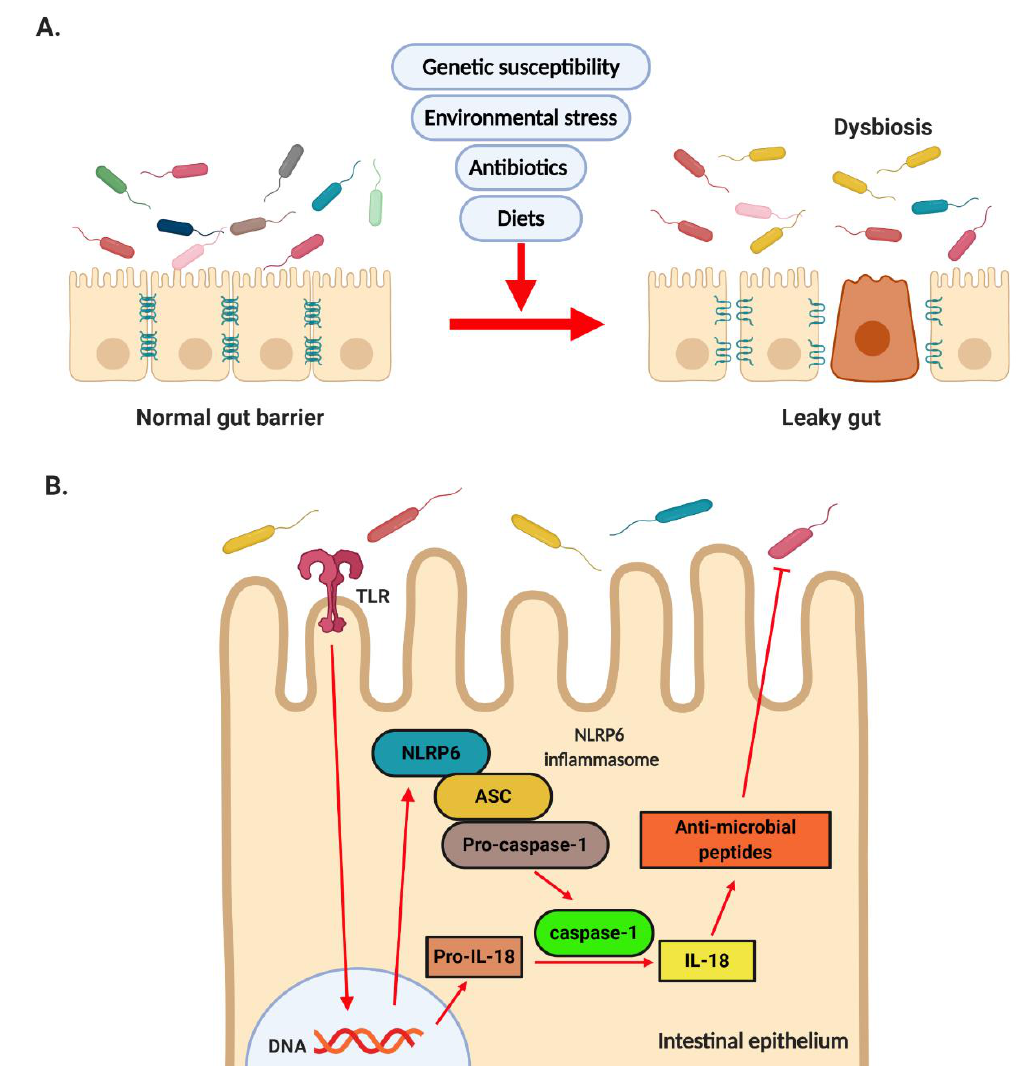
Figure 2. Dysbiosis and the role of NLRP6. ( A ) Dysbiosis induced by genetic susceptibility, environmental stress, diet, and gut microbiota results in disrupted tight junction and increased intestinal permeability. ( B ) Microbiota-derived factors activate NLRP6 inflammation via TLR signaling. Activation of NLRP6 results in induction of anti-microbial peptide synthesis and contributes to maintaining the homeostasis of gut microbiota.